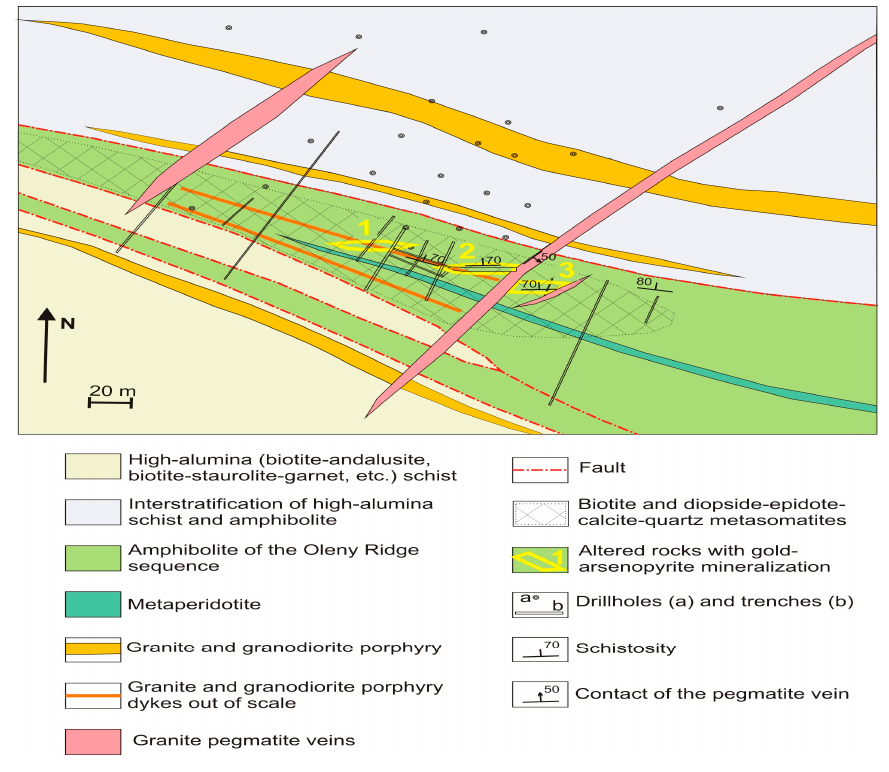
Figure 3. Schematic geological map of the Oleninskoe gold deposit.